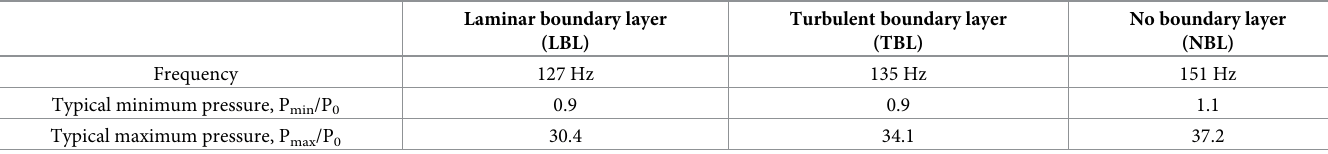
Table 2. Oscillation characteristics for different boundary layer cases.